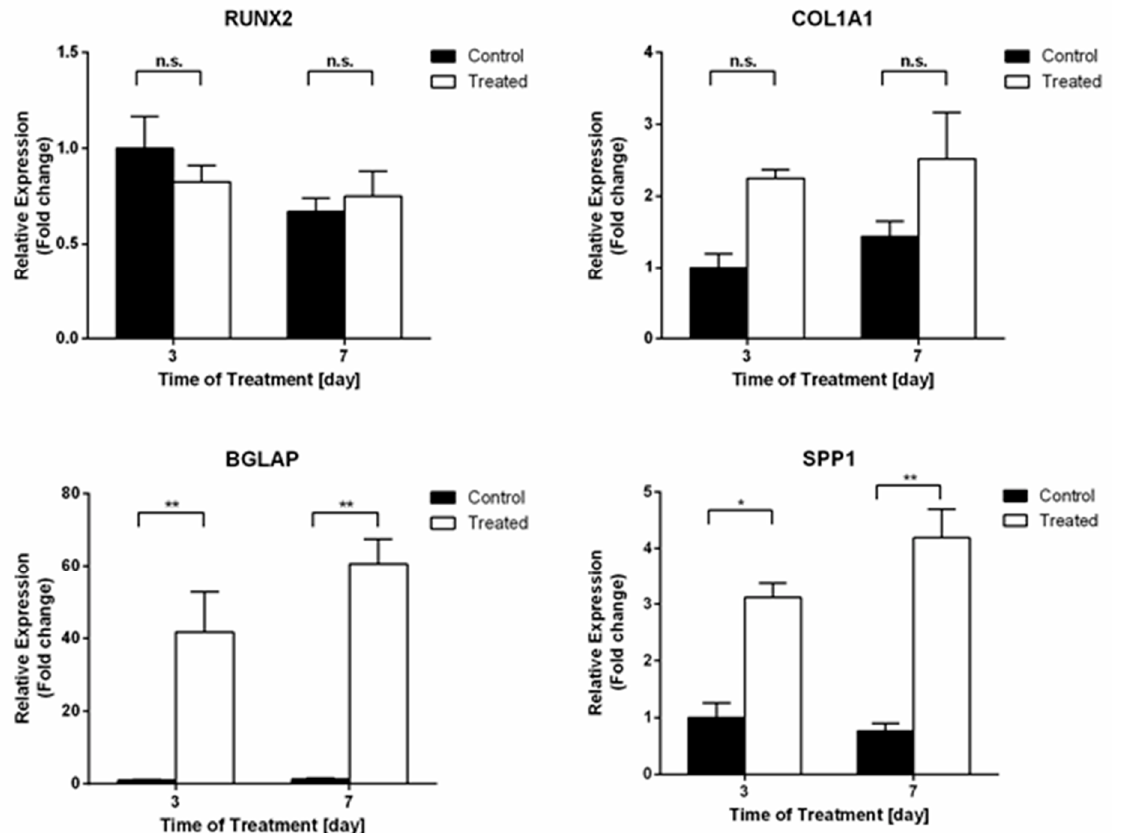
Figure 2. Analysis of SaOS2 cells cultured in 3D collagen scaffolds (3 and 7 days) treated with the osteogenic cocktail (20 nM 1 α ,25-Dihydroxyvitamin D3, 50 µM L-Ascorbic acid 2-phosphate, 10 mM β -Glycerophosphate). qPCR analysis of osteogenic markers ( RUNX2 , COL1A1 , BGLAP , and SPP1 ) was performed using GAPDH and HPRT1 as reference genes (2- ΔΔ C T method). Fold changes from control untreated cells at day 3 were calculated. Data are reported as mean ± SEM of three biological replicates. * p < 0.05; ** p < 0.01.